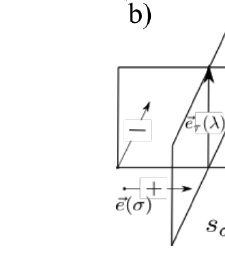
Figure 2. Circular matching of oriented normals to faces σ on the left and tangents along mesh edges λ on the right. The sign function s λ ( σ ) = ± 1 ( a ) takes values according to whether the orientation of the edge (cid:126) e τ ( λ ) coincides with the direction of rotation about the normal (cid:126) e ( σ ) . The sign function s σ ( λ ) = ± 1 ( b ) is defined similarly, but the contour is made up of oriented face normals (cid:126) e ( σ ) , and the rotation is around the tangent along the edges (cid:126) e τ ( λ )